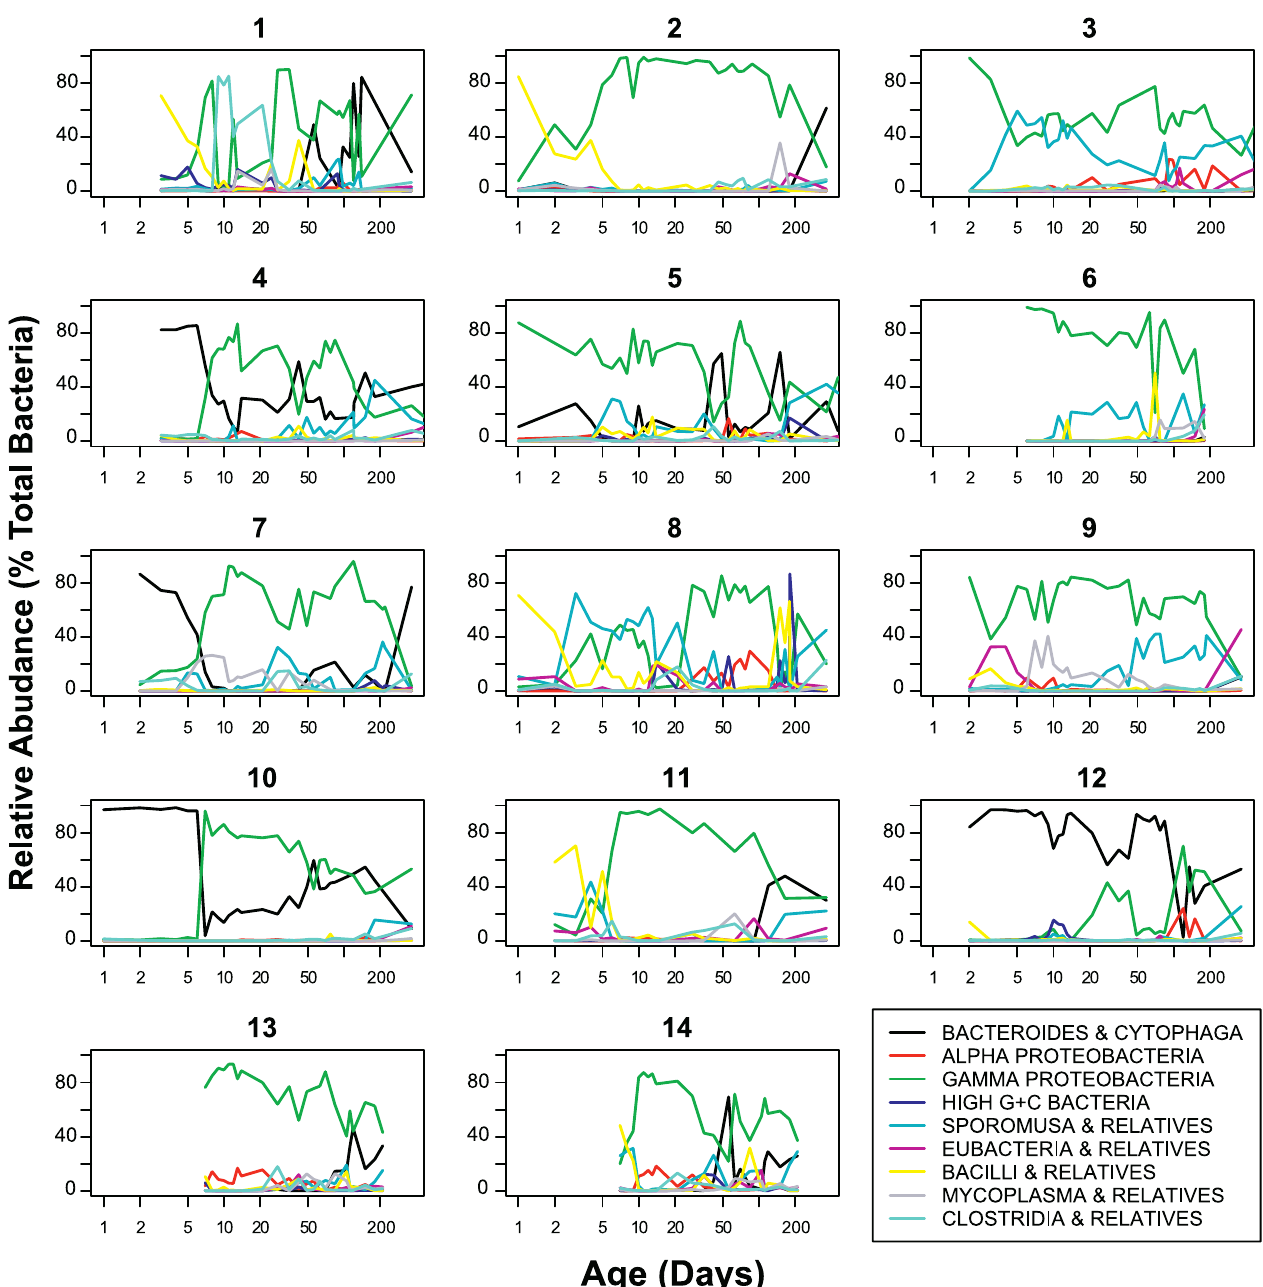
Figure 7. Temporal Profiles of the Most Abundant Level 3 Taxonomic Groups Level 3 taxonomic groups were selected for display if their mean (normalized) relative abundance across all baby samples was greater than 1%. The x - axis indicates days since birth and is shown on a log scale, and the y -axis shows estimated (normalized) relative abundance. For some babies, no values are plotted for the first few days because the total amount of bacteria in the stool samples collected on those days was insufficient for microarray-based